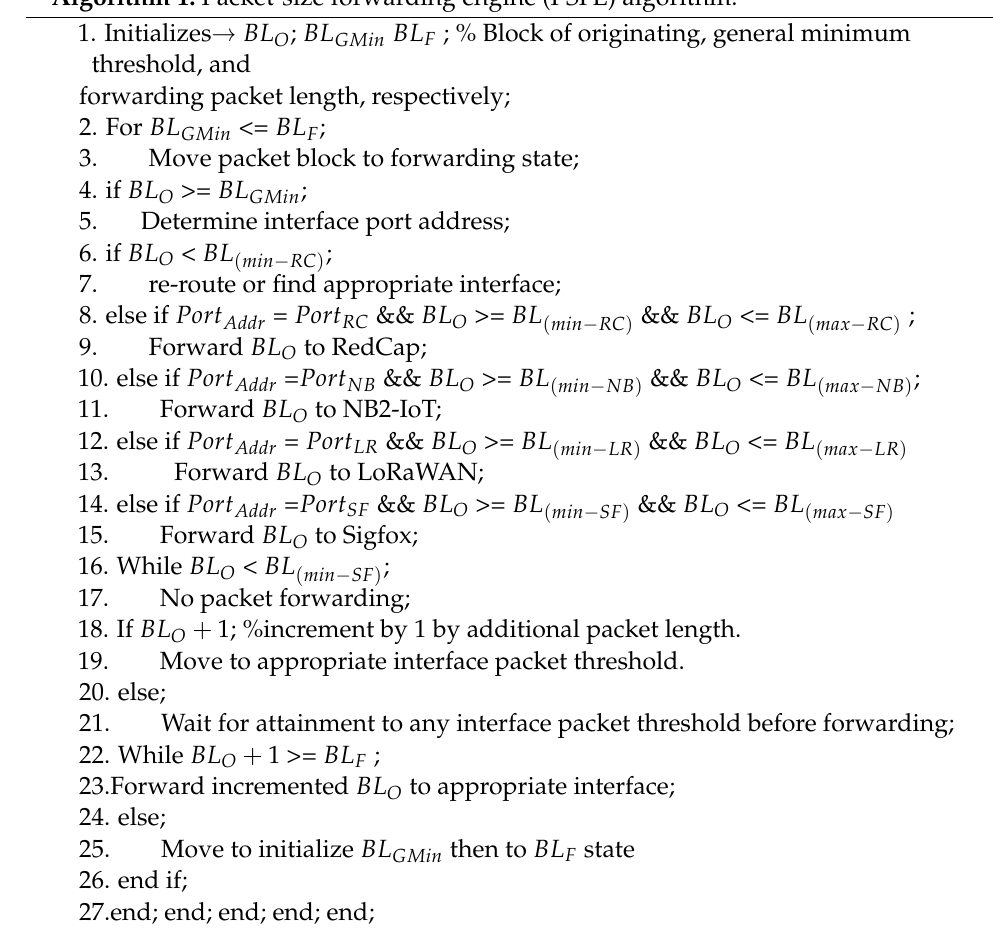
Algorithm 1: Packet-size forwarding engine (PSFE) algorithm.